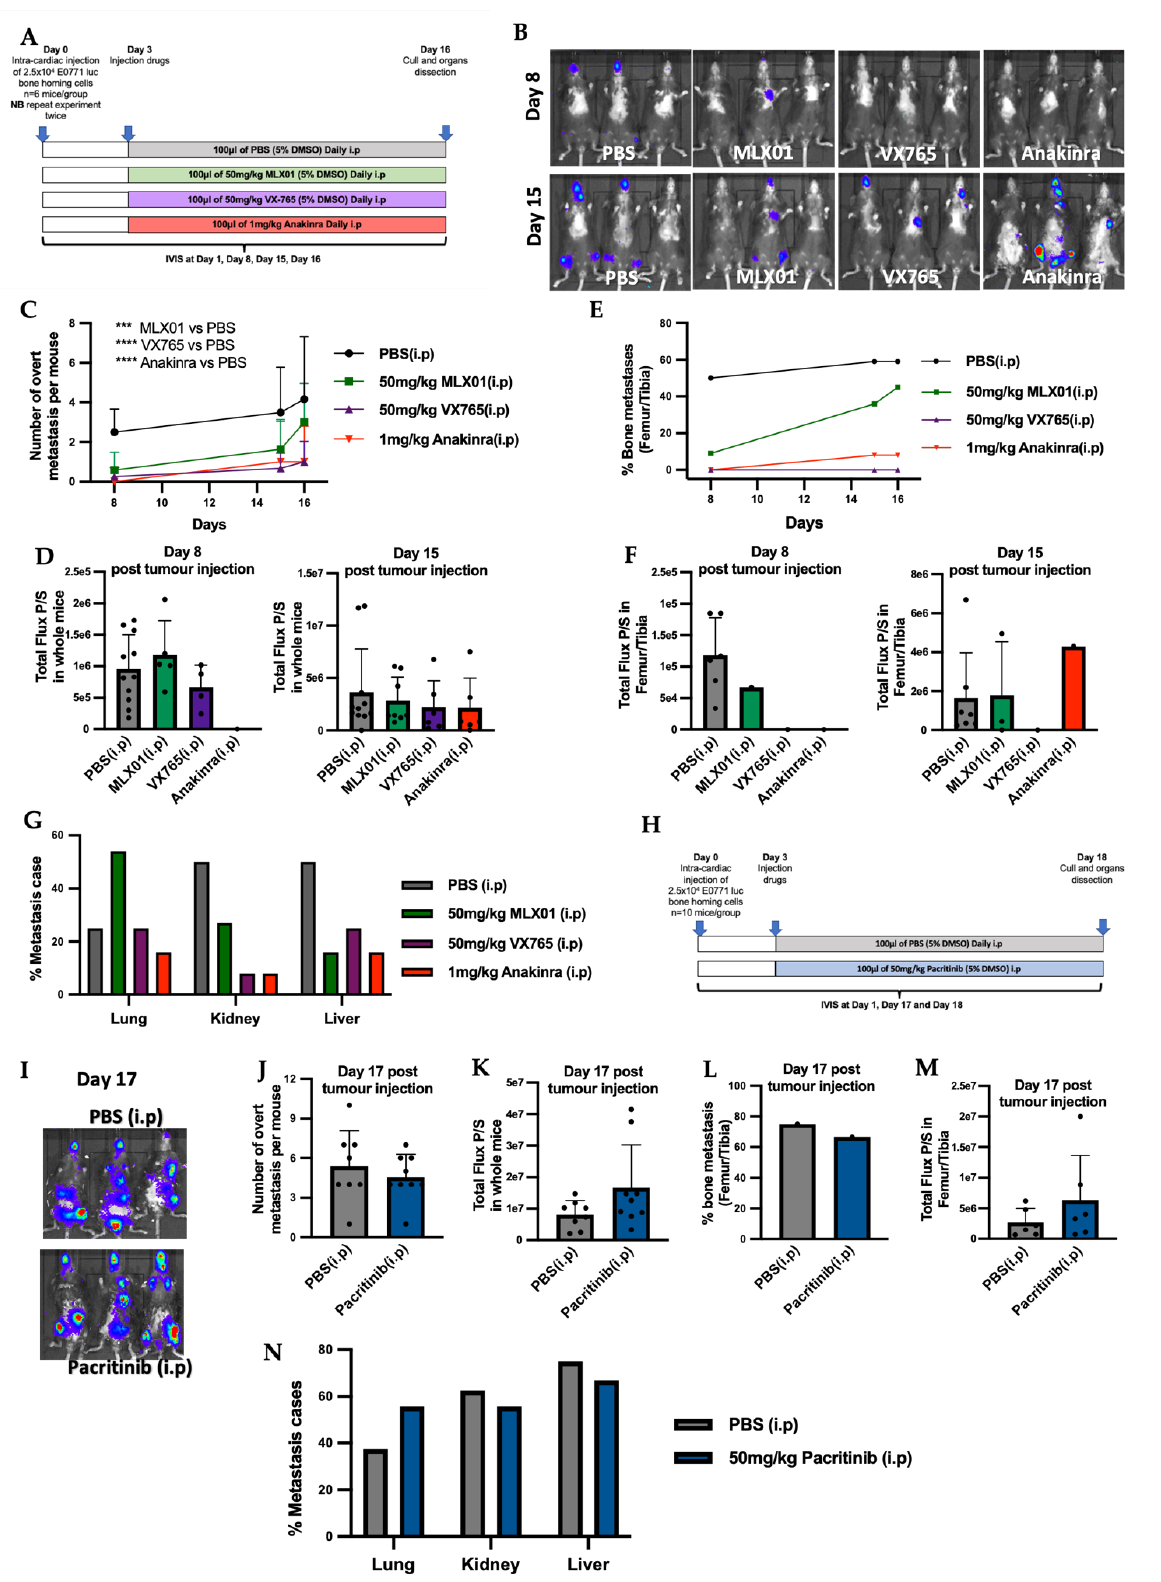
Figure 3. Inhibiting IL-1 signalling with IL1 β inhibitor MLX01, Caspase-1 inhibitor VX765 and IL1R antagonist Anakinra reduced metastatic outgrowth from E0771 cells disseminated in the